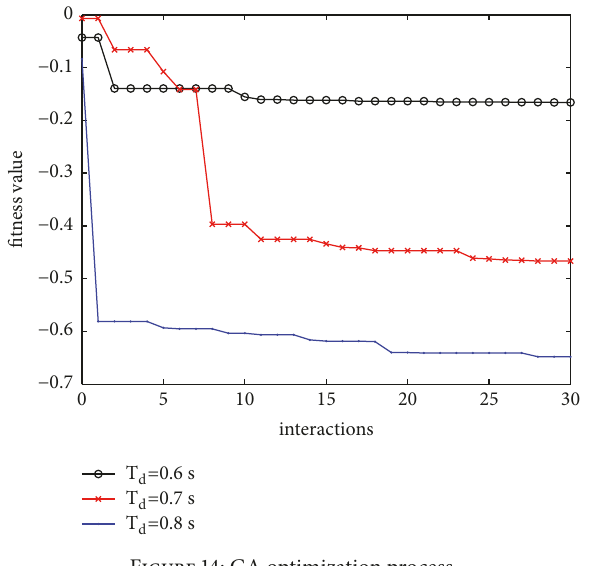
Figure 14: GA optimization process.